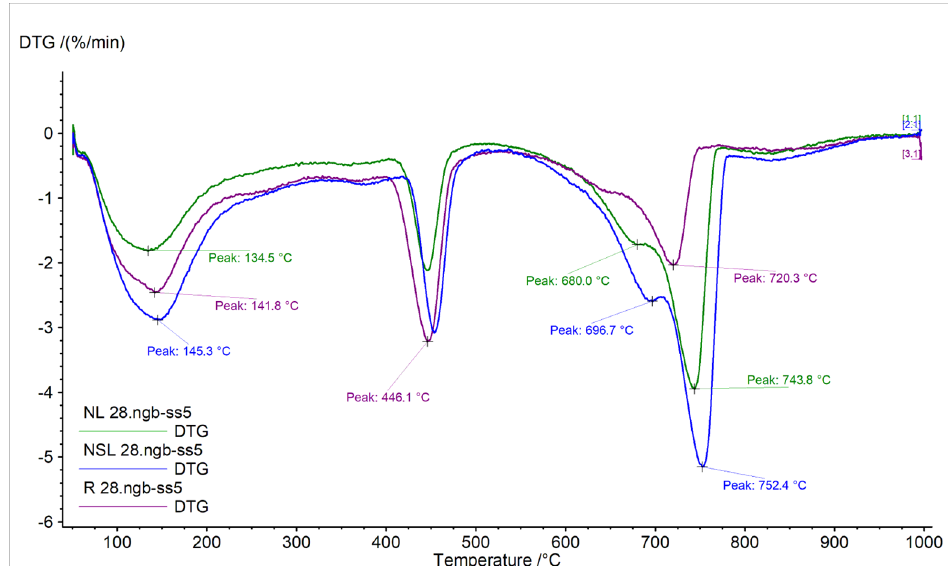
Figure 4. DTG curves of neat cement paste and nano-modified cement pastes cured in water immersion, 28 days.